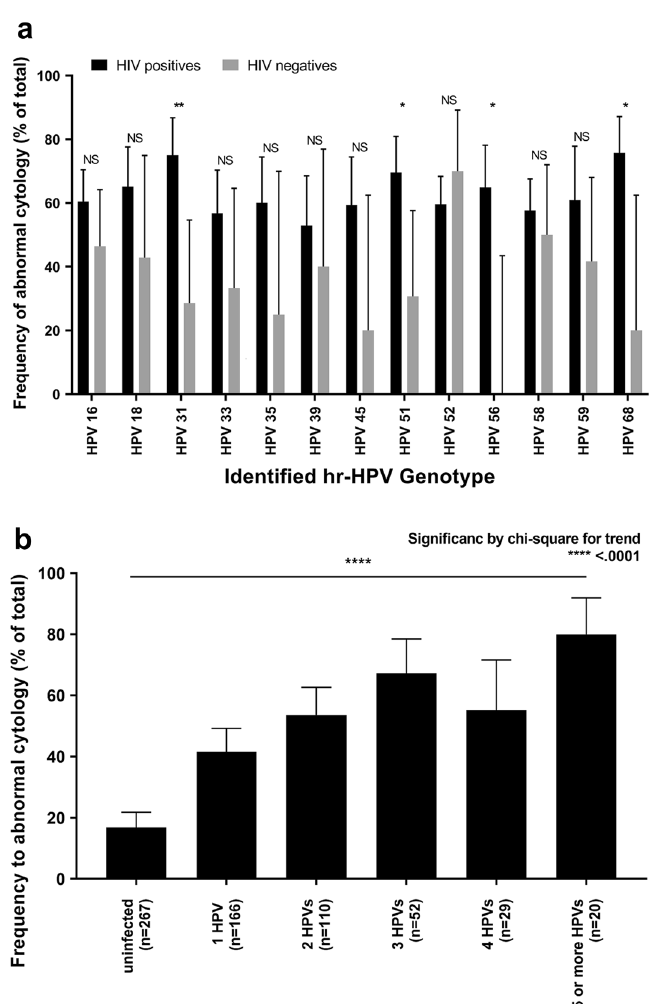
Figure 3. Frequency of abnormal anal cytology via anal swabs in HIV-infected and -uninfected patients. ( a ) The frequency of abnormal anal cytology results (ASC-US, LSIL, ASC-H, or HSIL) is presented in accordance with each hr-HPV genotype in both subjects (644). ( b ) The frequency of abnormal cytology results was calculated in accordance with the number of hr-HPV genotypes found in each subject (see Supplementary Table S2 for stratification by HIV serostatus). HPV human papillomavirus, hr-HPV high-risk types of human